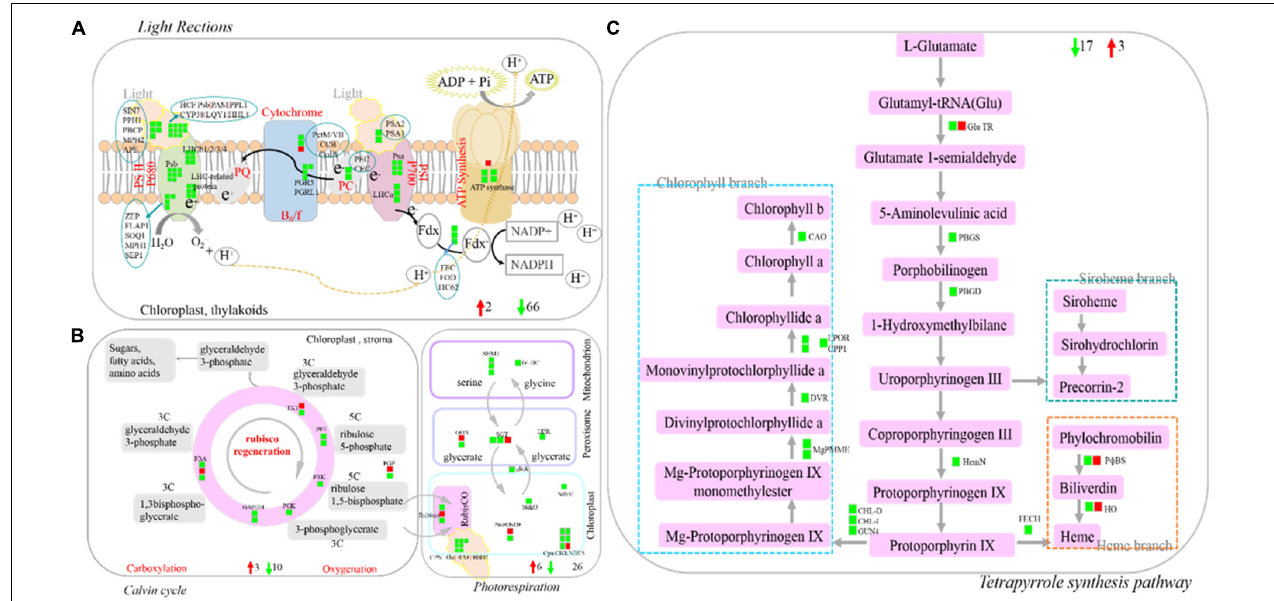
FIGURE 8 | Profile of DEGs involved in photosynthesis and terrapyrrole synthesis pathway. (A) DEGs involved in light reaction of photosynthesis. (B) DEGs involved in Calvin cycle and photorespiration. (C) DEGs involved in Tetrapyrrole synthesis pathway. DEGs were mapped to the photosynthesis diagram according to Log2 fold change (SB/DB). Up-regulated DEGs or down-regulated DEGs were shown in red or green, respectively. Detailed annotation information of DEGs was shown in Supplementary Table 8